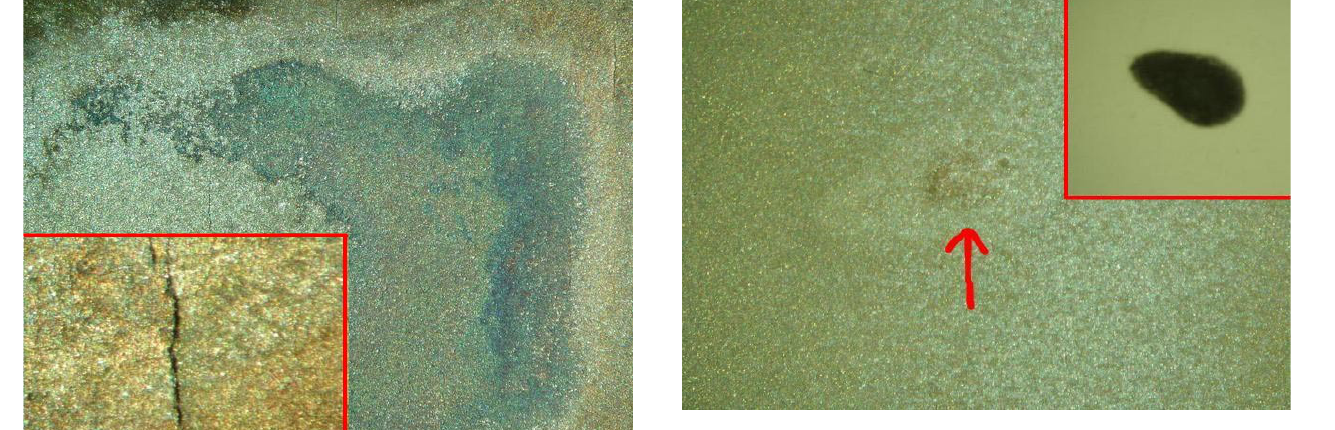
FIG. 7. (Color) Downstream surface of a target dosed with the ILC2 mode (target 5). A beam in the ILC 2 mode was injected twice. The horizontal size of this picture corresponds to 5 mm. There is a small colored area that can be identified as the beam trace because a clear black spot was observed at the same position in the thermal paper, as shown in the right-upper corner.